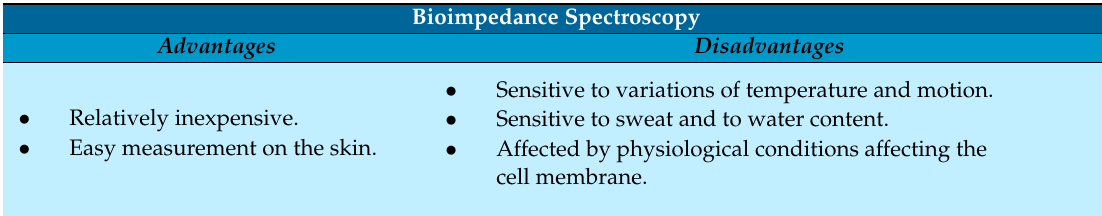
Table 19. Advantages and disadvantages of bioimpedance